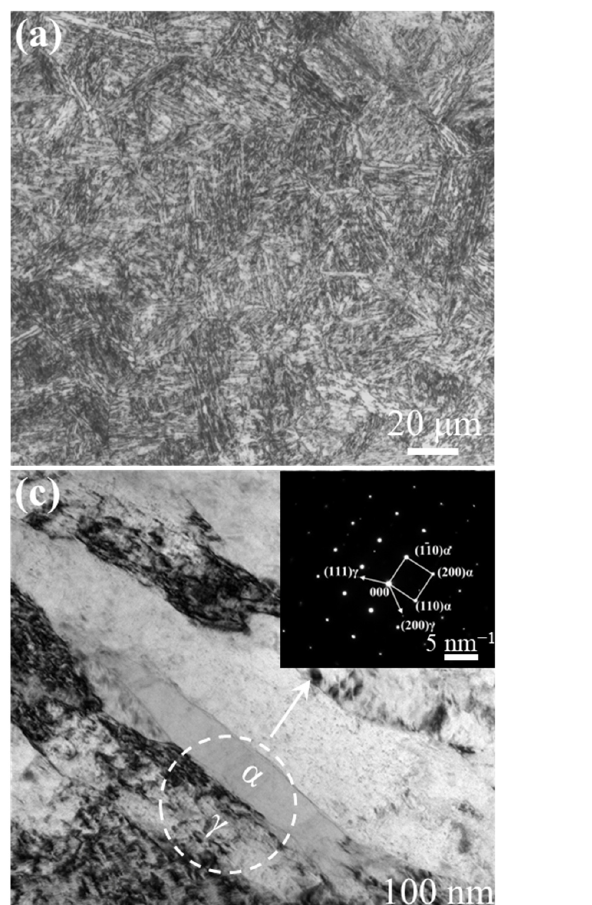
Table 3. Hardness, chemical composition (wt%) and yield strength of the representative wheel ma- terials reported in previous studies.